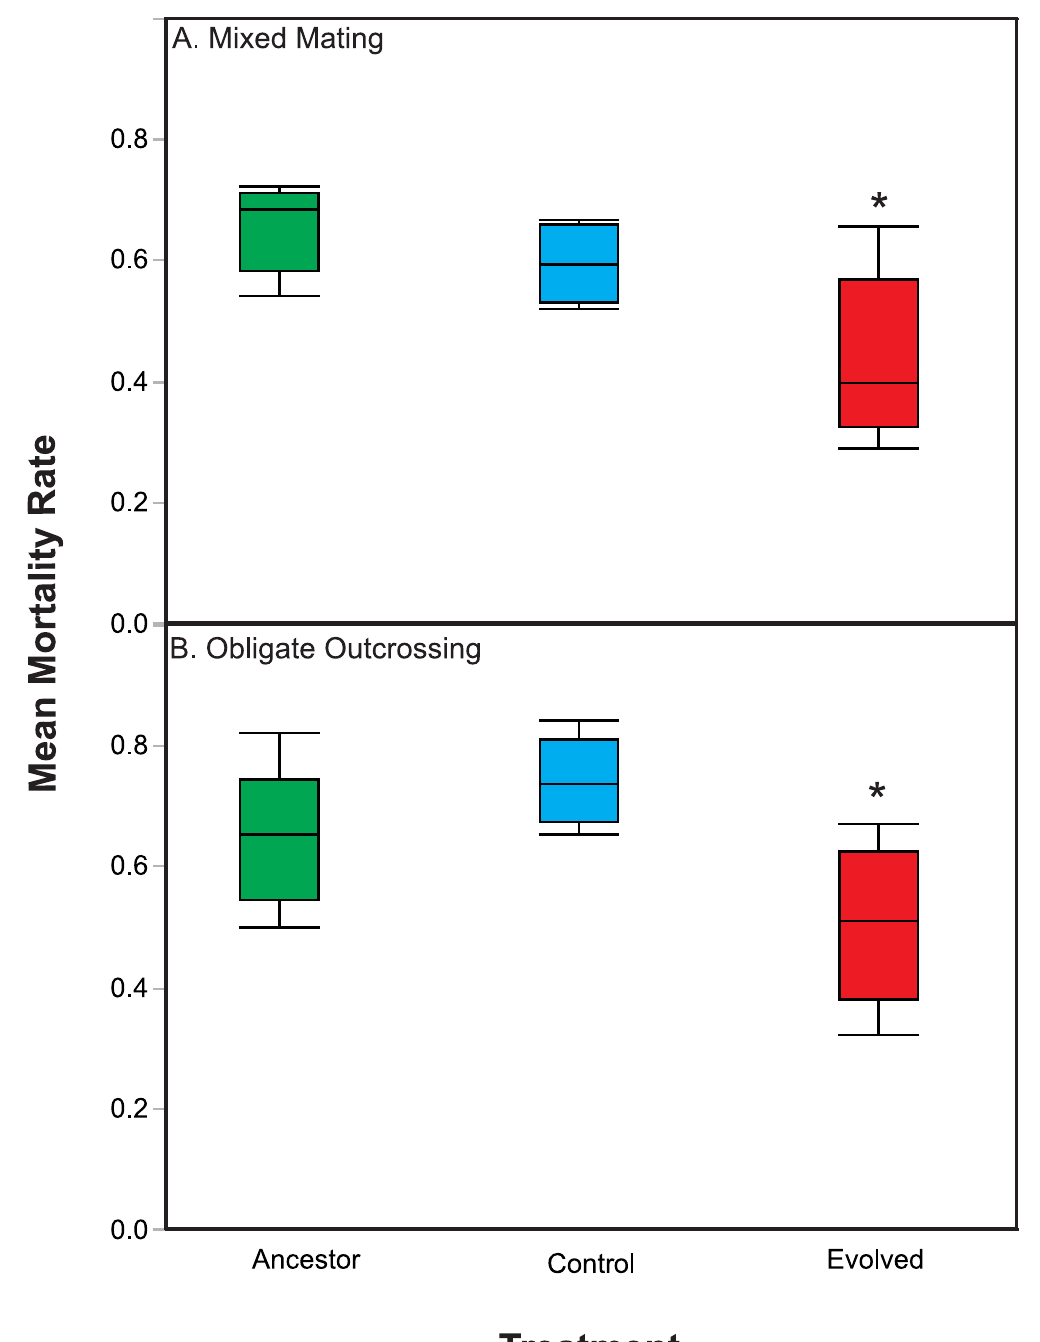
PLOS ONE | https://doi.org/10.1371/journal.pone.0181913 August 9,